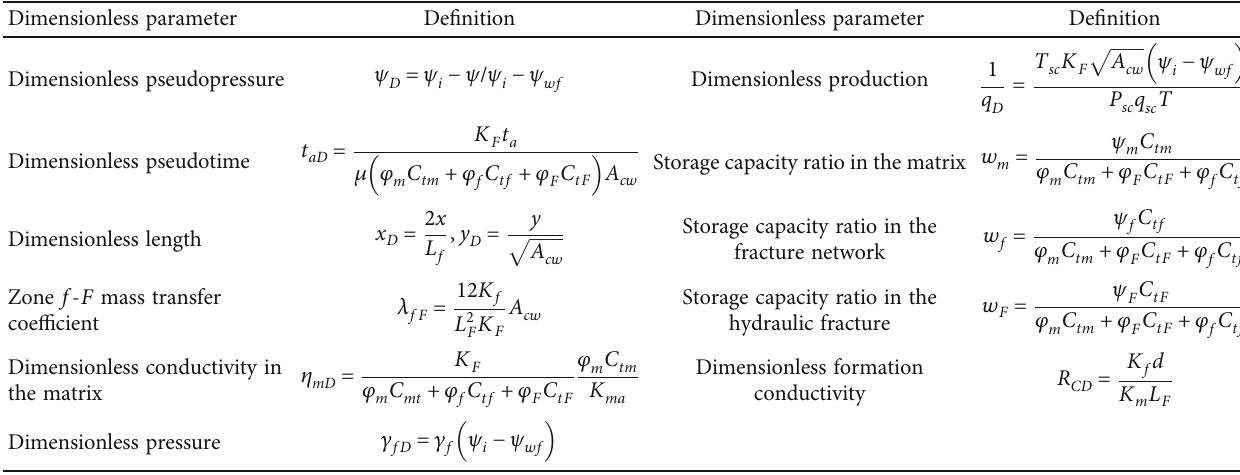
Figure 11: One-dimensional seepage physical model of shale gas fractured horizontal well. Table 2: Dimensionless parameter de fi